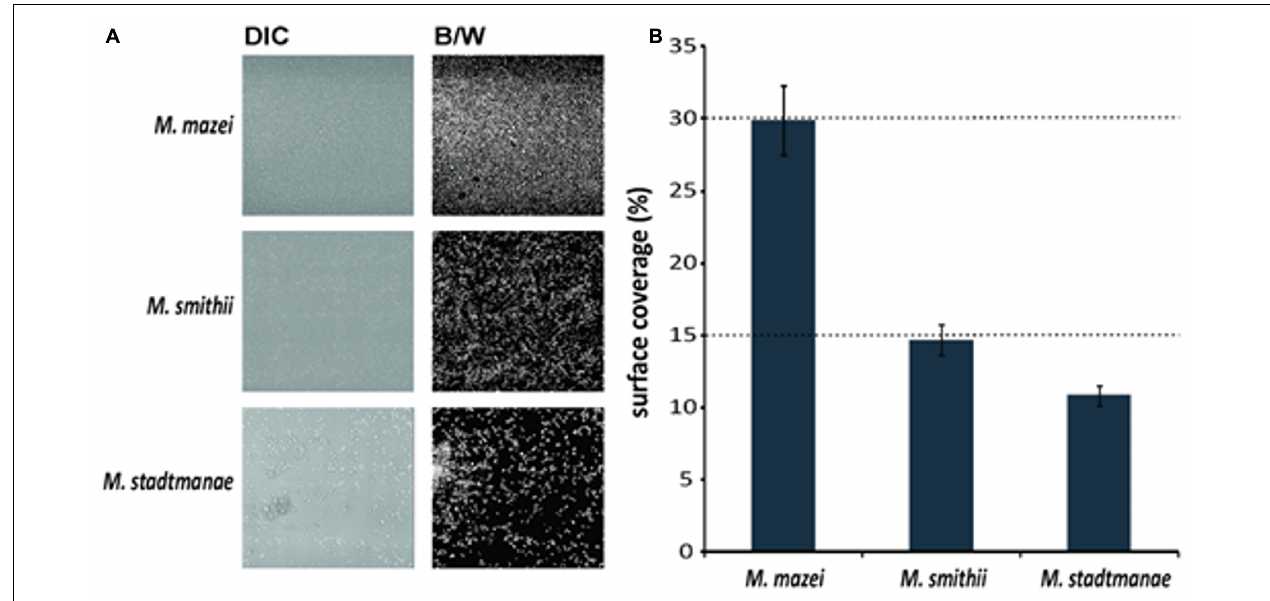
converted into black/white (B/W; A , right panel) to calculate the surface coverage.The ratio of B/W pixels was determined and used to obtain the surface coverage (B) .The mean and standard deviations of three biological replicates are